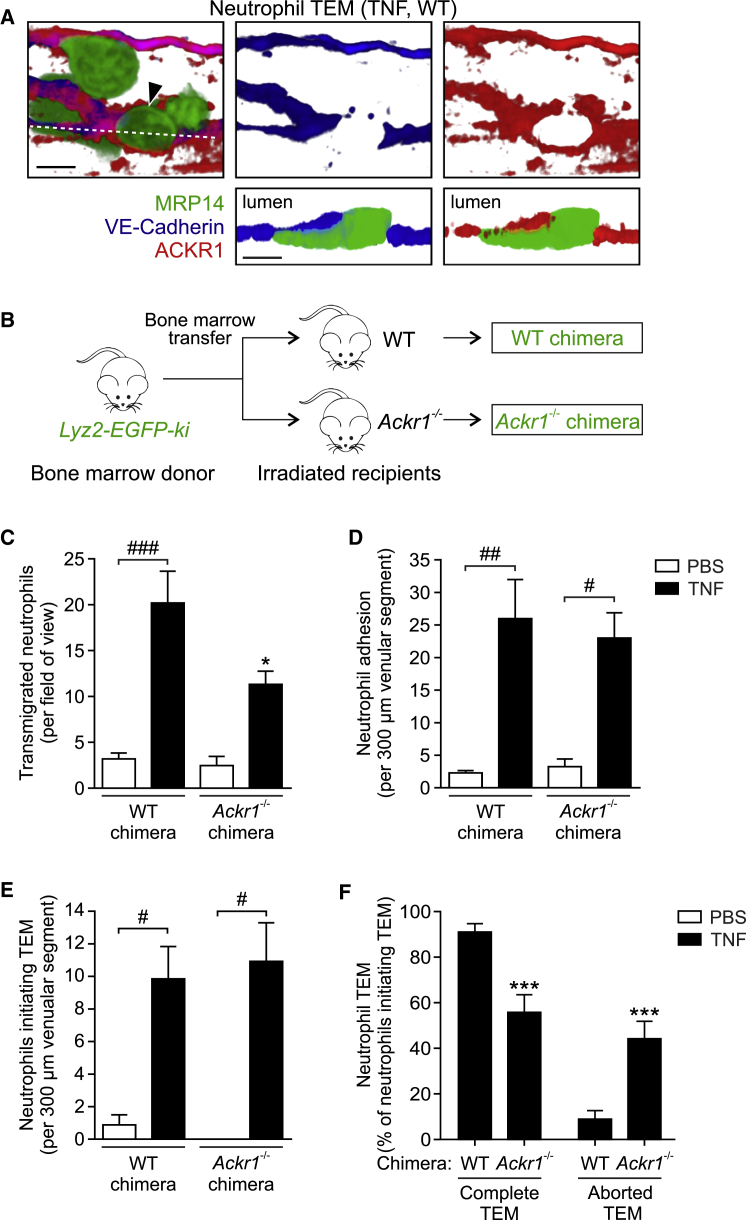
Endothelial ACKR1 Facilitates Decisive Luminal-to-Abluminal TEM(A) Confocal images showing a neutrophil (arrow) migrating through an EC junction in a TNF-stimulated cremasteric venule of a WT mouse IF stained for MRP14, VE-Cadherin, and ACKR1. Luminal (top) and cross-sectional images (bottom) along dashed line; representative of 3 independent experiments; scale bars, 5 μm.(B) Scheme illustrating the generation of chimeric mice exhibiting Lyz2-EGFP-ki hematopoietic cells (GFP+ neutrophils) and WT or Ackr1−/− non-hematopoietic cells.(C–F) Quantification of neutrophil extravasation (C), adhesion to ECs (D), initiating TEM (E), and undergoing complete or aborted TEM (F) in cremaster muscles of WT and Ackr1−/− chimeras after local PBS or TNF injection (n = 3–8 mice per group, 26 independent experiments) as analyzed by confocal IVM. Means ± SEM, ∗p < 0.05, ∗∗∗p < 0.001 relative to WT chimeras and #p < 0.05, ##p < 0.01, ###p < 0.001 as indicated.See also Figure S6.